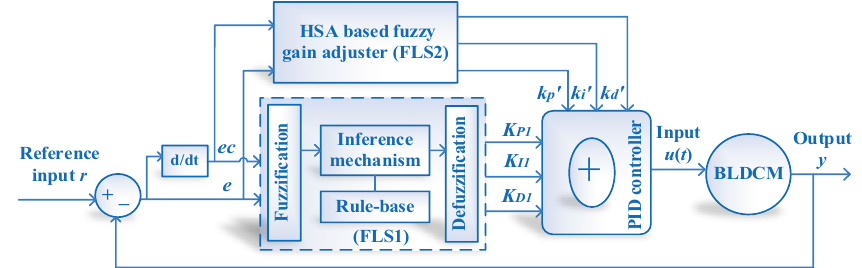
Figure 3. The architecture of the BLDCM control